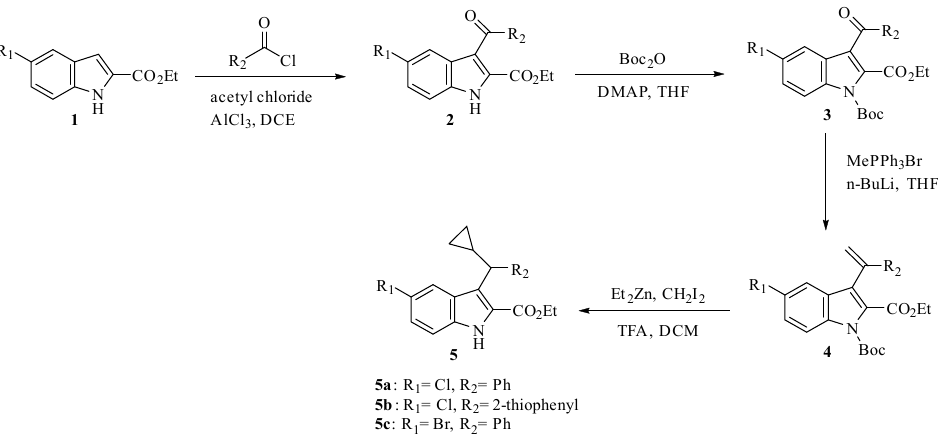
Scheme 1. The synthesis of non-nucleoside scaffolds as HIV reverse transcriptase inhibitors.